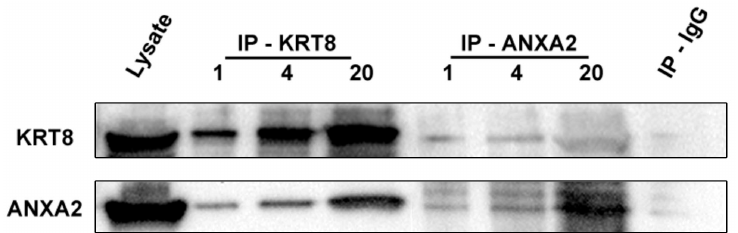
Figure 5. Magnetic bead-based immunoprecipitation was performed on ACT1 lysates (see Methods) using KRT8 (IP-KRT8 group), annexin-A2 (IP-ANXA2 group), and non-targeting mouse IgG (IP-IgG) antibodies. Immunoprecipitation eluates (at increasing loading amounts) and unprocessed ACT1 lysate (positive control) were separated by polyacrylamide gel and immunoblot performed with KRT8 and annexin-A2 antibodies.